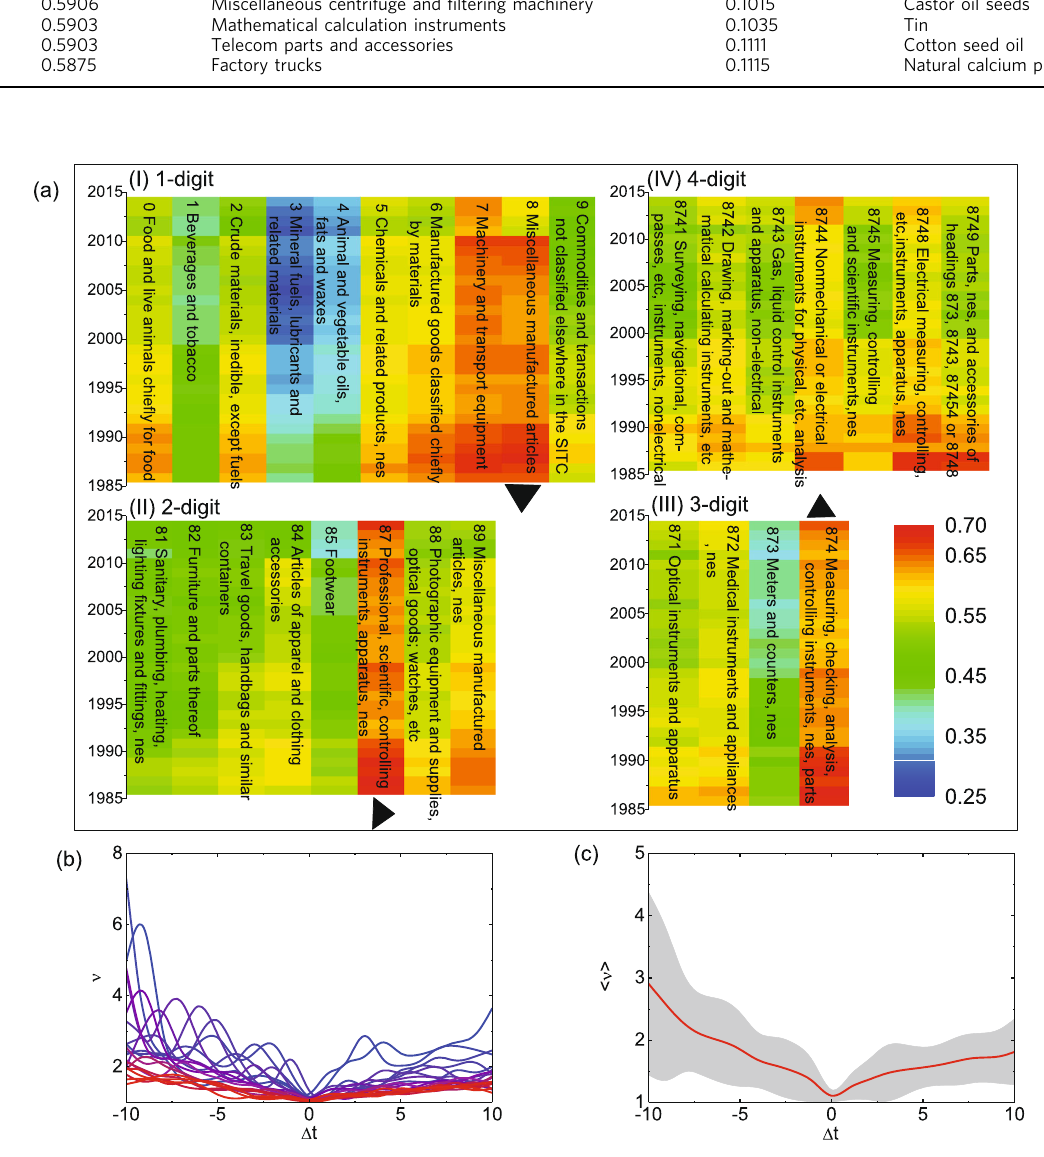
Fig. 3 Nestedness evolution in four levels from 1986 to 2014. a The highest nested products in different levels. (i) 1-digit. The fi rst level products that can be regarded as ten sectors. (ii) 2-digit. We select the highest nested sector in the fi rst level, i.e., nine miscellaneous manufactured articles. The ninth sector is subdivided into eight divisions. (iii) 3-digit. We also select the highest nested division in the second level that is 87 Professional, scienti fi c, controlling instruments, apparatus, nes. The group can be subdivided into four groups. (iv) 4-digit. At last, we again select the highest nested group, which is 874 Measuring, checking, analysis, controlling instruments, nes, parts. This subgroup consists of seven products. b We investigate that how the ranking positions of the set of 20 top nested products change in 20 years. We choose the top 20 nested products from 1986 to 2005. The current seems as t and the time period Δ t ∈ [ − 10, 10]. c Averaging the change rate of the top 20 nested products from 1986 to 2005. The gray area represents the error bar.